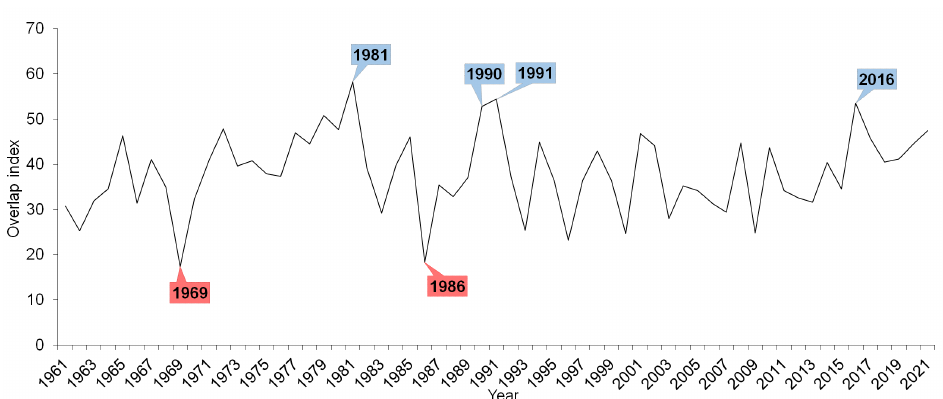
Figure 6. Overlap index for all observed overlaps of the studied phenological stages of herbs, shrubs, trees, and bird species in 1961 – 2021. The blue colour indicates years with a high number of overlapping days, and the red colour indicates years with a low number of overlapping days.